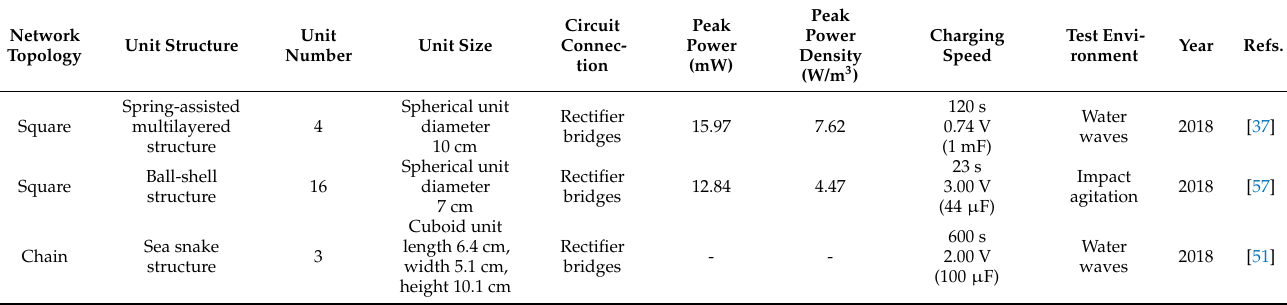
Table 1. Summary of typical TENG